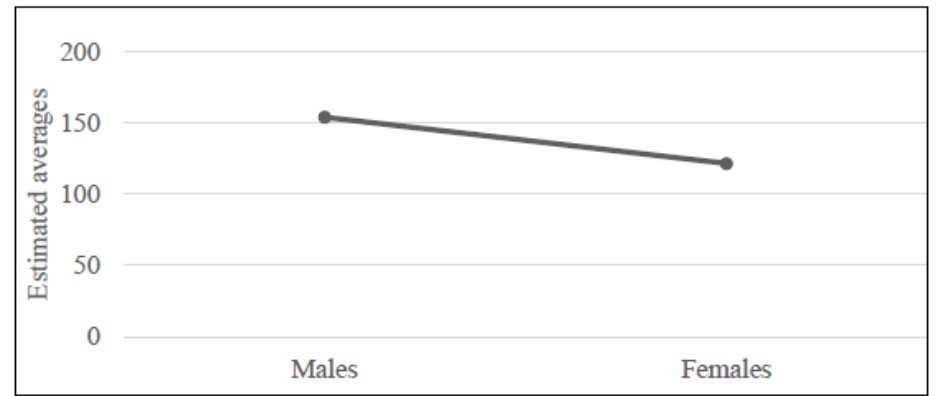
Figure 4. Use of vamos as a rectifying reformulator according to the gender of the subjects.